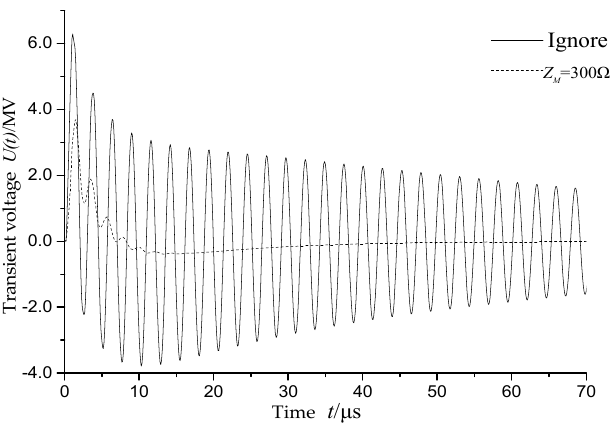
Figure 8. The influence of the wave impedance on the transient potential of the nacelle.